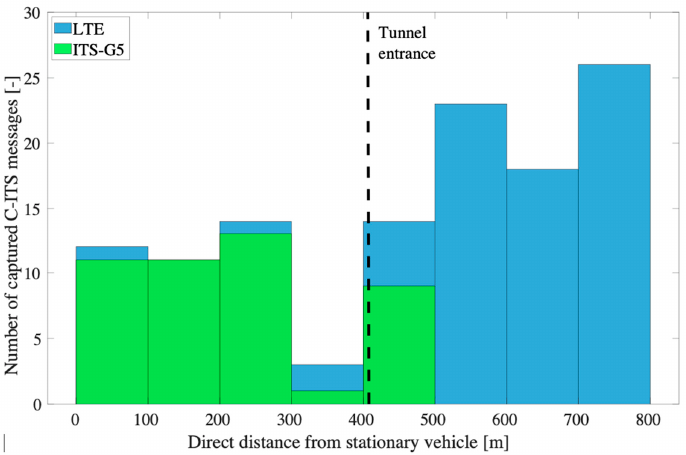
Figure 8. Captured C ‐ ITS messages in terms of distance from the stationary vehicle.